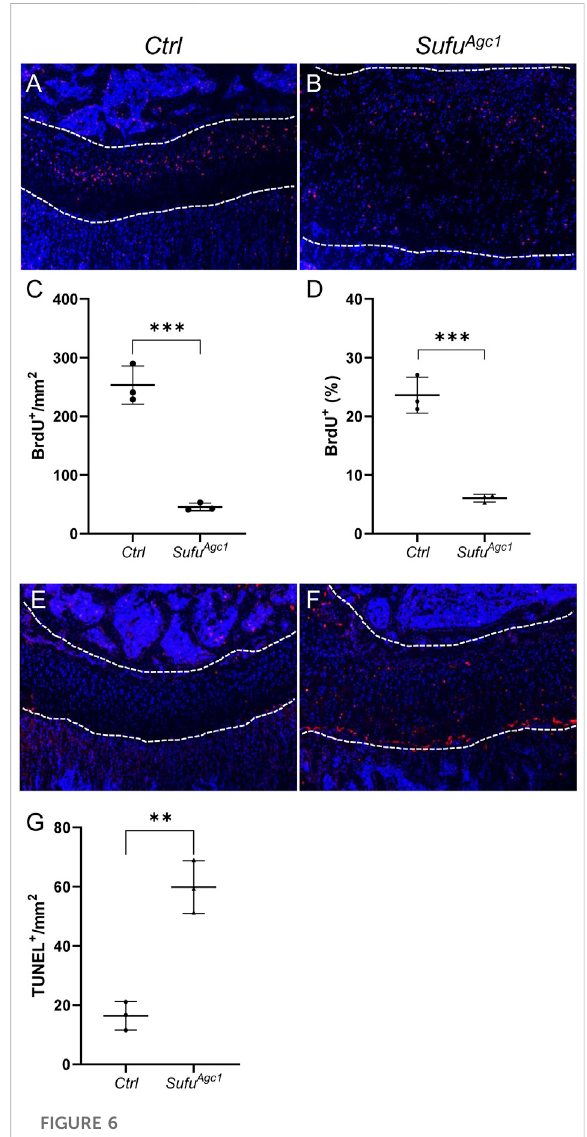
FIGURE 6 Chondrocyte-speci fi c deletion of Sufu in juvenile mice impaired chondrocyte proliferation and promoted cell apoptosis (A,B) BrdU staining of proximal tibial growth plates from P30 Ctrl (A) and Sufu Agc1 mice (B) . BrdU-labeled cells were shown in red and nuclei were stained in blue (C,D) Quanti fi cation of the number (C) and percentage (D) of BrdU- positive cells in resting and columnar zones of proximal tibial growth plates from P30 Ctrl and Sufu Agc1 mice (E,F) TUNEL assays of proximal tibial growth plates from P30 Ctrl (E) and Sufu Agc1 mice (F) . Apoptotic cells were shown in red and nuclei werecounterstainedinblue (G) Quanti fi cationof TUNEL- positive cells normalized to areas of proximal tibial growth plates in P30 Ctrl and Sufu Agc1 mice. All mice were treated with 5 daily doses of tamoxifen starting at P14. All quantitative data were shown as individual data points from each mouse together with mean ± standard deviation. p values were obtained by Student ’ s t-test and degrees of statistical signi fi cance were designated by different numbers of asterisk (*) in the fi gures: *, p < 0.05 ; **, p < 0.01 ; ***, p < 0.001 ; ****, p < 0.0001